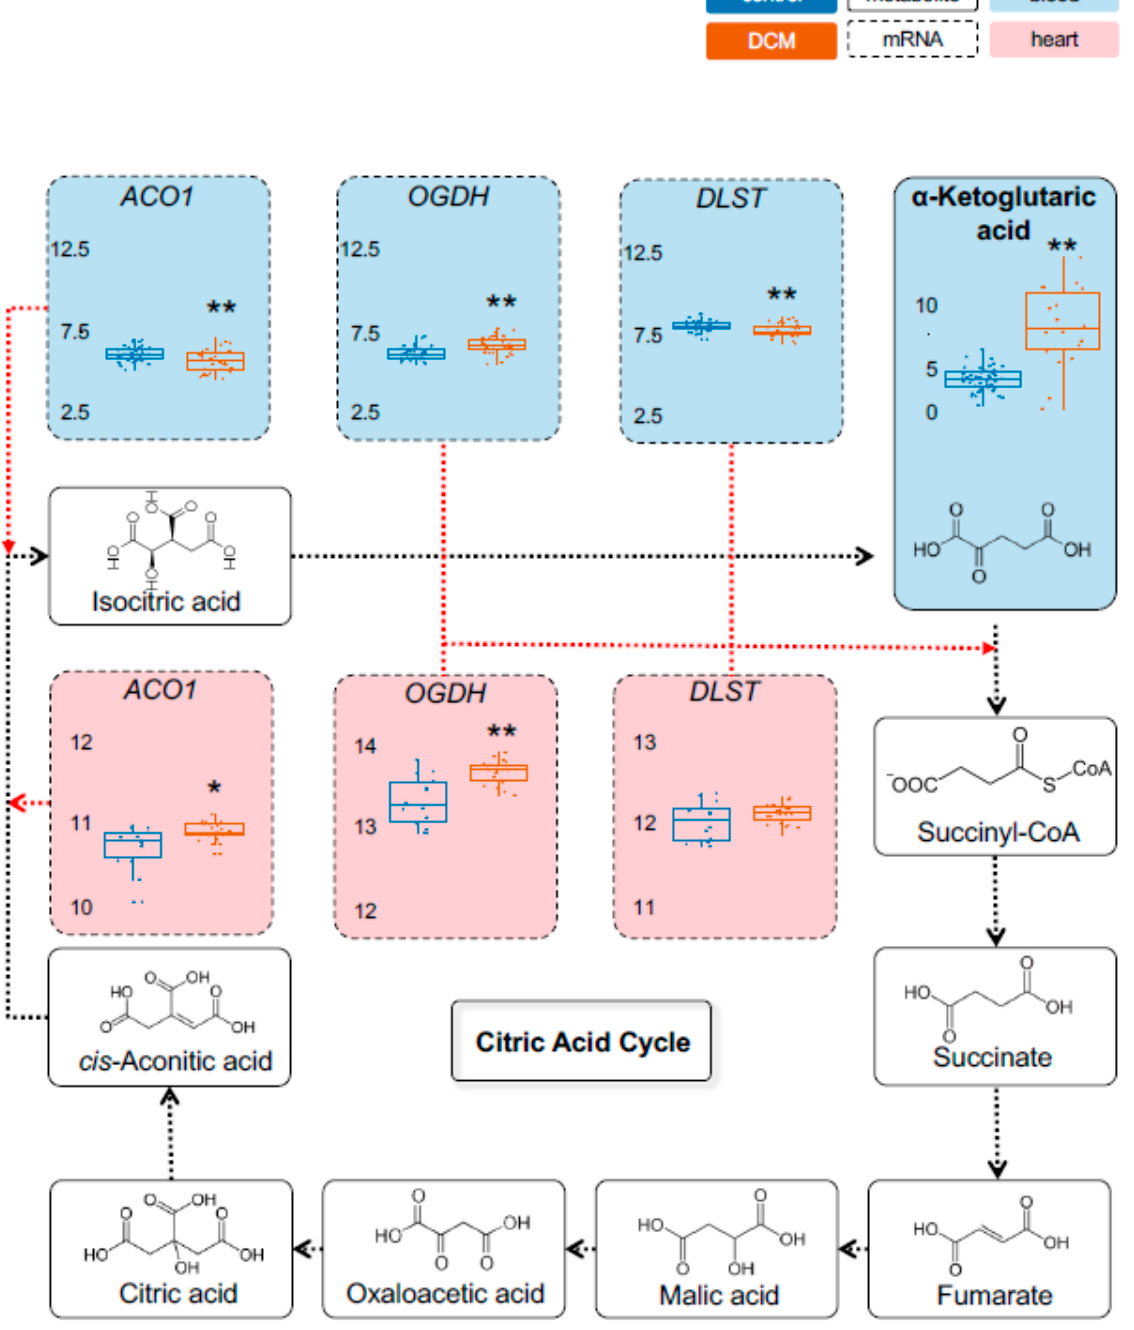
Figure 3. Detection of metabolic dysregulation in citric acid cycle. In the citric acid cycle, several mRNA expression changes were observed, with OGDH being upregulated in mononuclear blood cells and myocardial tissue. The metabolite α -Ketoglutaric acid was (as a consequence) strongly increased and could potentially serve as new biomarker in HF. Control (CTRL) samples are depicted in blue. Values for samples from the Dilated Cardiomyopathy (DCM) cohort are orange. Significance values are given. Boxes with dashed lines indicate mRNA and with full lines metabolomics expression in blood (light blue shading) and left-ventricular heart tissue (pale red shading). RNAseq expression is given as (rlog-)normalized read counts. Metabolite concentrations are shown as [ µ M]. *: p < 0.05; **: p < 0.01. ACO1 = Aconitase 1; OGDH = oxoglutarate dehydrogenase; DLST = dihydrolipoamide s-succinyltransferase.